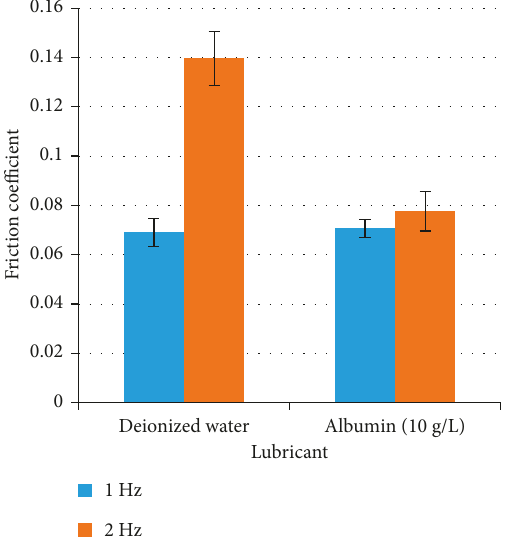
Figure 5: Effect of speed under 1N load condition.